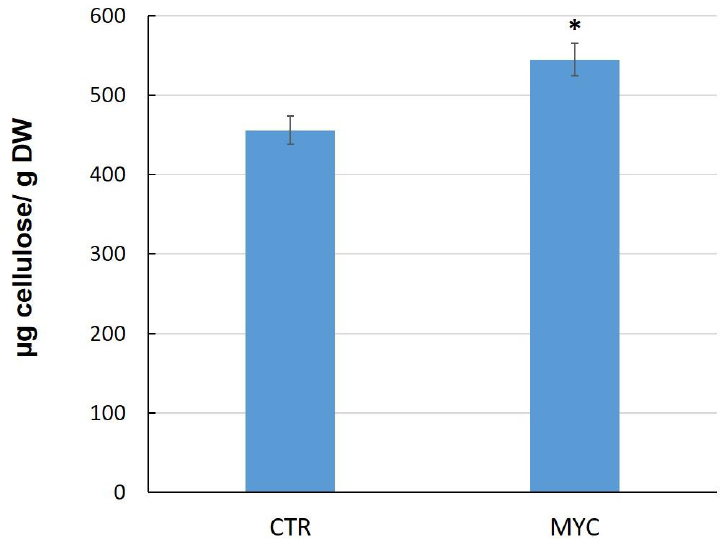
Figure 3. Normalized fold expression of cuticle-related genes in leaves of mycorrhizal tomato plants. Gene expression was determined by qRT-PCR (2 −∆∆Ct ). Values represent the average ±SE of the nor- malized relative expression (MYC/CTR) from three independent biological experiments (n = 3 per experiment). Ubiquitin was used as a reference gene for data normalization. (*) represent signifi- cantly different means between MYC/CTR according to the statistical analysis (Student ’ s t -test, p ≤ 0.05). Bars, ±SE. (ENOYL RED: Enoyl reductase; ACSL: Long-chain-fatty-acid-CoA ligase; ACSL4: Long-chain-fatty-acid-CoA ligase 4; ACYL CoA THIO: Acyl-CoA thioesterase).